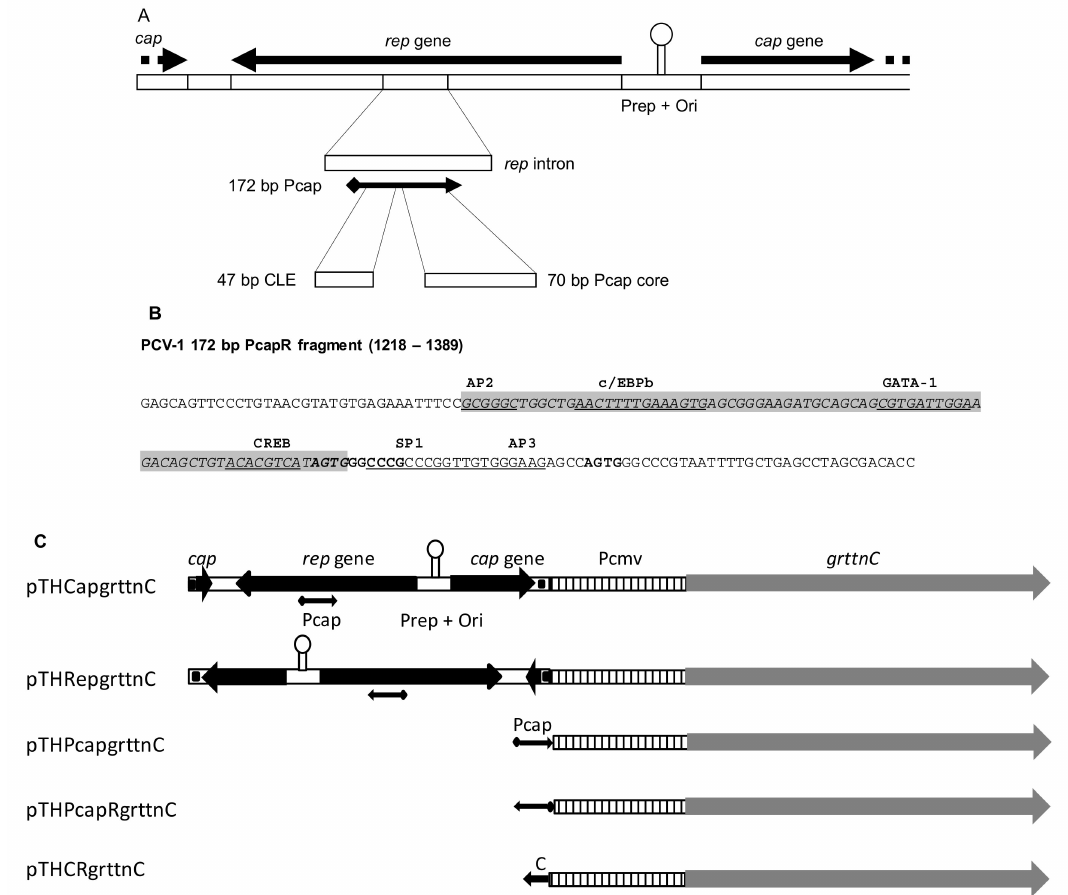
Figure 1. Porcine circovirus type-1 (PCV-1) genome arrangement. ( A ) Diagram of the linearized PCV-1 genome, depicted in the orientation cloned into pTHCapgrttnC. The rep intron is enlarged and the capsid gene promoter (Pcap) indicated. The core and conserved late elements (CLE) components of Pcap are shown. rep = replication associated protein gene, cap = capsid protein gene, Prep = rep gene promoter, Ori = origin of replication, core = composite host transcription factor binding site. ( B ) DNA sequence of 172 bp PcapR fragment. Putative host transcription factor binding sites are indicated and underlined, CLE motifs are in bold and the minimal PcapR sequence (1252–1238; as identified by Mankertz and Hillenbrand [13]) is highlighted in gray. PCV-1 accession number Y09921. ( C ) Schematic diagrams of plasmids showing assembly of PCV elements. Pcmv = Cytomegalovirus (CMV) promoter, grttnC = gene encoding polyprotein of HIV-1 Gag, reverse transcriptase (RT), Tat and Nef, C = 70 bp Pcap core. Figure reproduced from Tanzer et al. [3] under the Creative Commons Attribution (CC-BY) license as specified by BioMed